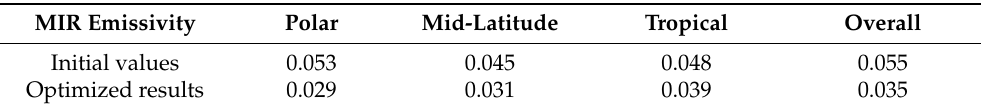
Table 3. RMSEs of MIR emissivity for different